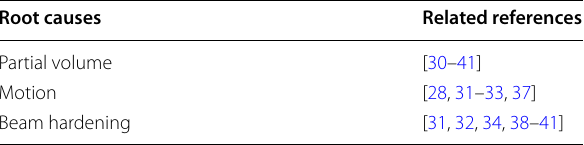
The most cited factor is partial volume averaging, followed by motion artifacts and beam hardening artifacts